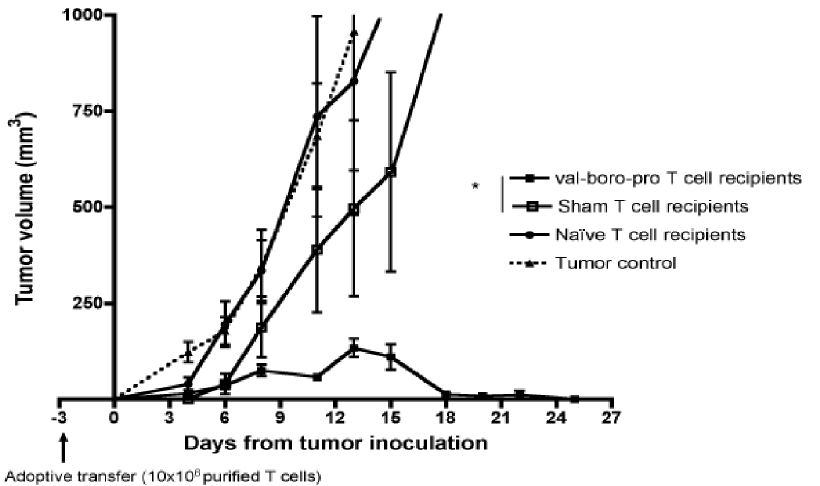
Figure 4. Val-boroPro treatment improves functionality of adoptively transferred T cells. Donor C57BL/6 female mice were inoculated with 1 6 10 6 MB49 on day 2 20 and treated with 20 m g Val-boroPro or saline 5 6 /week for two weeks. On day 2 3, purified donor T cells from pooled donor lymph nodes were transferred into Rag1 2 / 2 recipients intravenously (1 6 10 7 /mouse). On day 0, Rag1 2 / 2 mice were challenged with high-dose MB49 (3 6 10 6 ). Recipients of T cells from tumor-bearing Val-boroPro treated donors (closed squares) had significantly smaller tumors than in recipients of T cells from tumor-bearing saline treated donors (open squares) (p , 0.05 for all timpoints after day 12). Open squares, recipients of T cells from non tumor-bearing donors; closed triangles, Rag 2 / 2 mice injected with MB49 but not receiving T cells. Figure 4 is representative of 4 experiments.